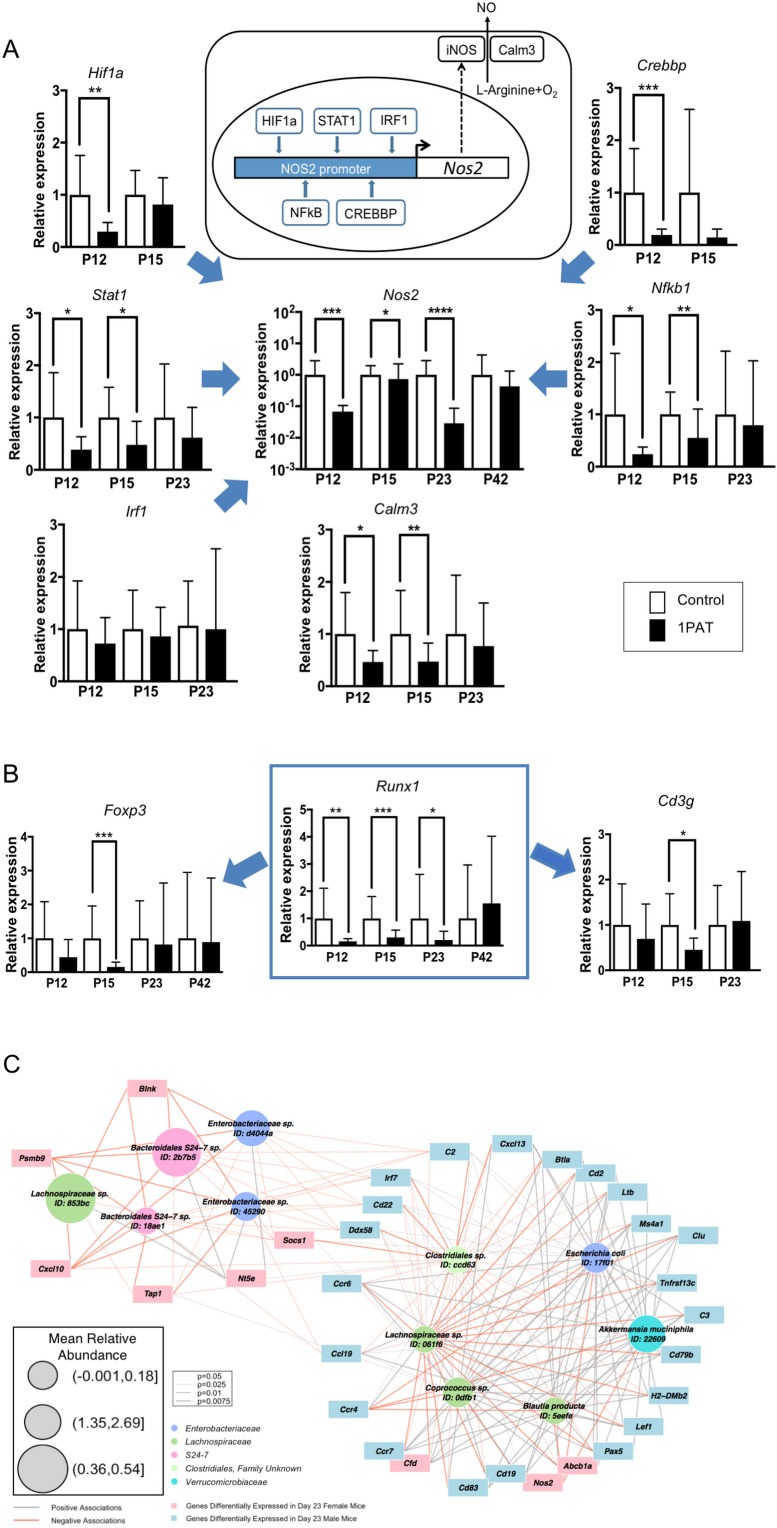
Differential effects of 1PAT on transcription of specific ileal genes in P12 to P42 mice, as determined by RT-qPCR, and microbe-host gene expression interactions.(A) Transcription of the inducible nitric oxide synthase gene Nos2 and its upstream transcription factor genes Stat1, Nfkb1, Hif1a, Crebbp, and Irf1, as well as Nos2 partner Calm3. (B) Transcription factor Runx1 and its downstream immune genes Foxp3 and Cd3g. n = 10 ~22 samples per group, and mean values with STDEV were shown. Statistical significance determined by the Mann Whitney test. *p<0.05; **p<0.01; ***p<0.001; and ****p<0.0001. (C) CompPLS framework selecting significant associations identified differential taxa and ileal gene expression in P23 male mice. The 43 immune genes profiled by NanoString were selected as the targeted significantly differential genes, and the model found 31 (72%). Red and gray edges indicate negative and positive model-selected associations, respectively. Edge width in the network indicates statistical significance as derived from empirical p values after bootstrapping. Node sizes are scaled to the mean relative abundance for each taxon, and color-coded by OTU family. [See also Figure 6—figure supplements 1–3 and Supplementary files 3 and 4].10.7554/eLife.37816.033Figure 6—source data 1.Relative expression values for 10 ileal genes.